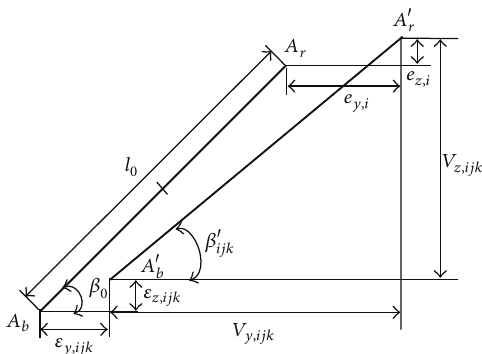
Figure 4: Diagram showing the calculation of the deformation of the ball with 𝑗 = 1 and 𝑘 = 2